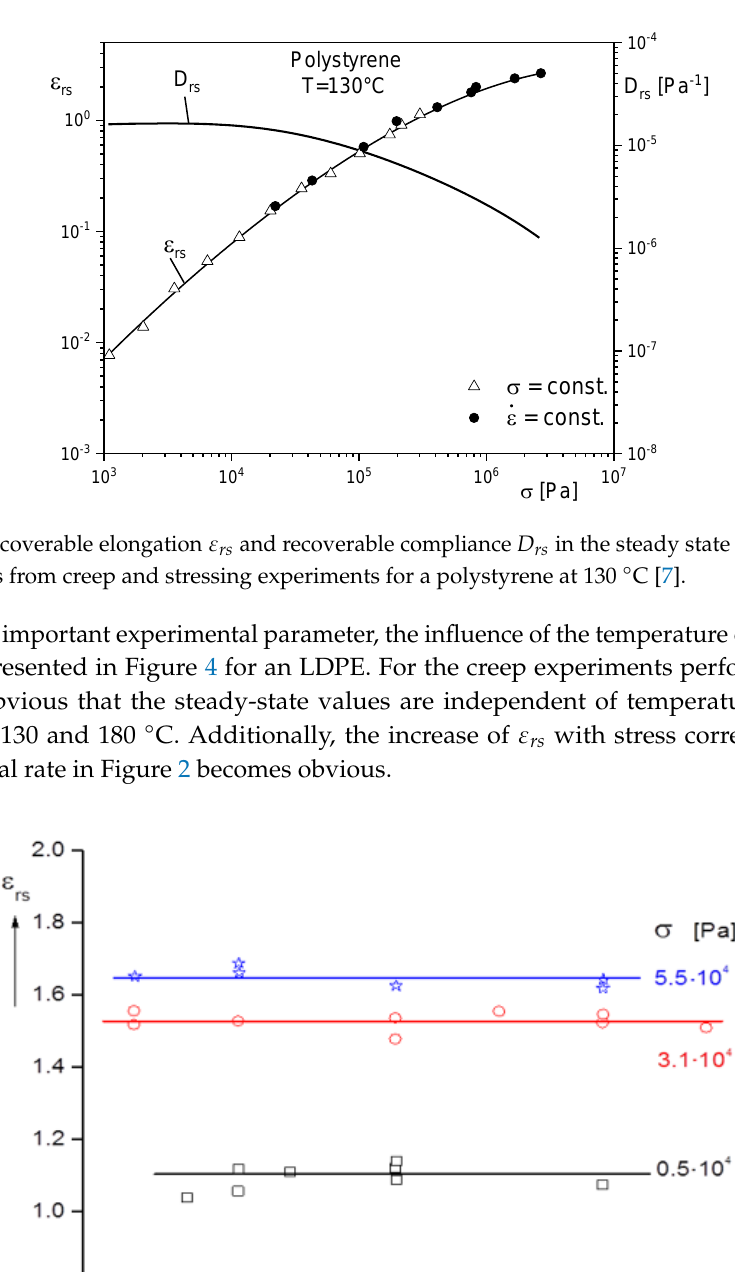
Figure 4. Steady-state recoverable elongation 𝜀 𝑟𝑠 as a function of temperature for an LDPE at different tensile stresses σ up to the steady state indicated by a time-independent elongational rate [13].